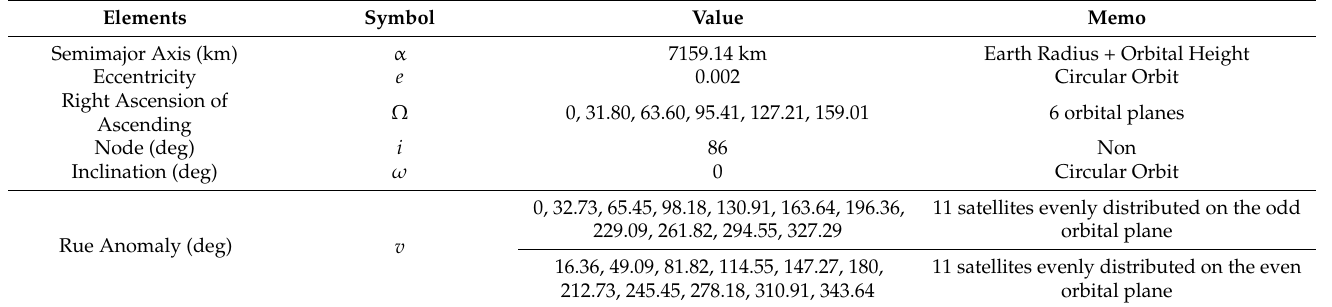
Table 3. Keplerian elements of the Iridium constellation.